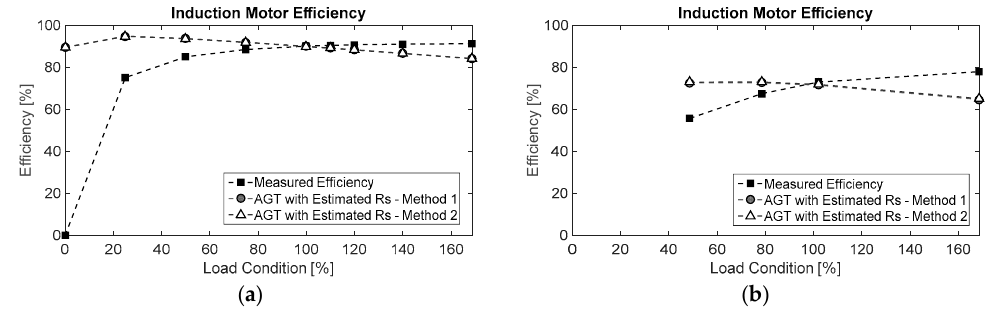
Figure 15. IM efficiency estimation using the proposed methodology—( a ) simulation and ( b ) IM efficiency estimation using the proposed methodology—( a ) simulation and experimental results. ( b ) experimental